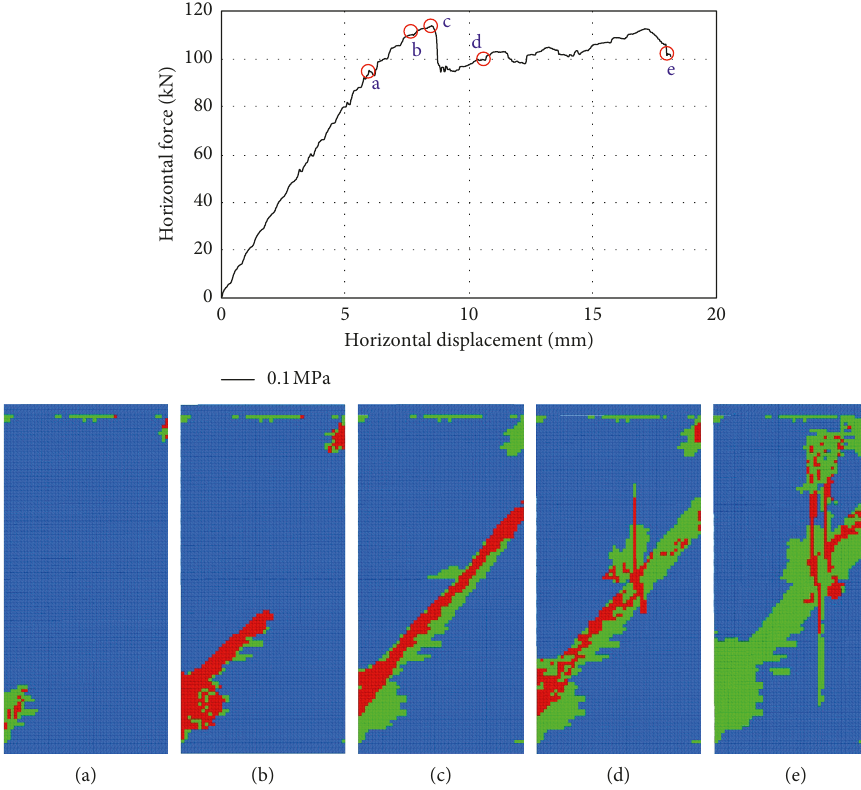
Figure 6: Evolution of damage state in the wall with 0.1MPa prestress rods: Points (a) 95kN, 5.96mm; (b) 110 kN, 7.80mm; (c) 113kN, 8.50mm; (d) 99kN, 10.60mm; (e) 101 kN,